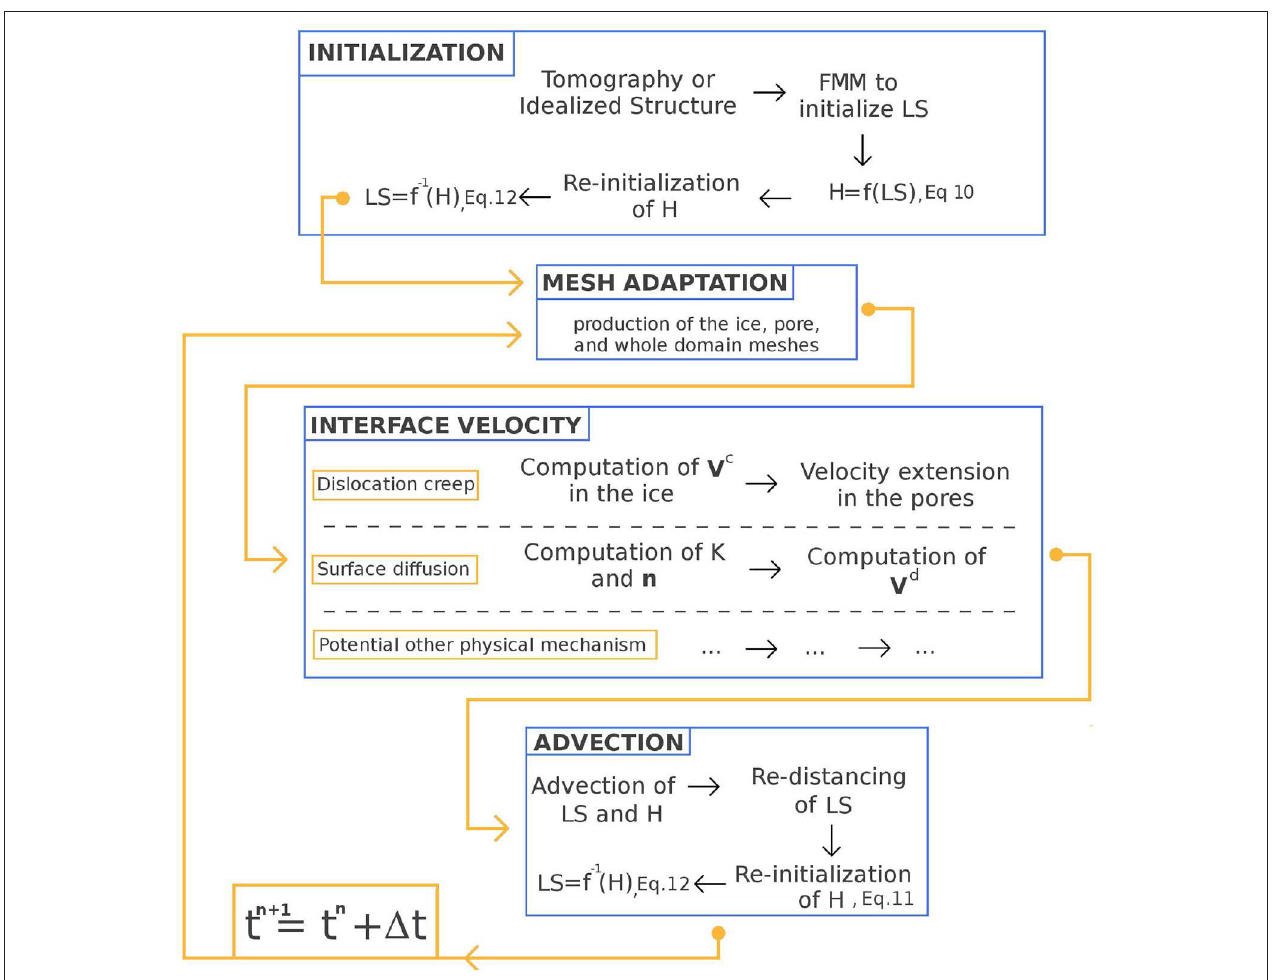
FIGURE 2 | Scheme of the model algorithm. Each blue box represents a core stage of the